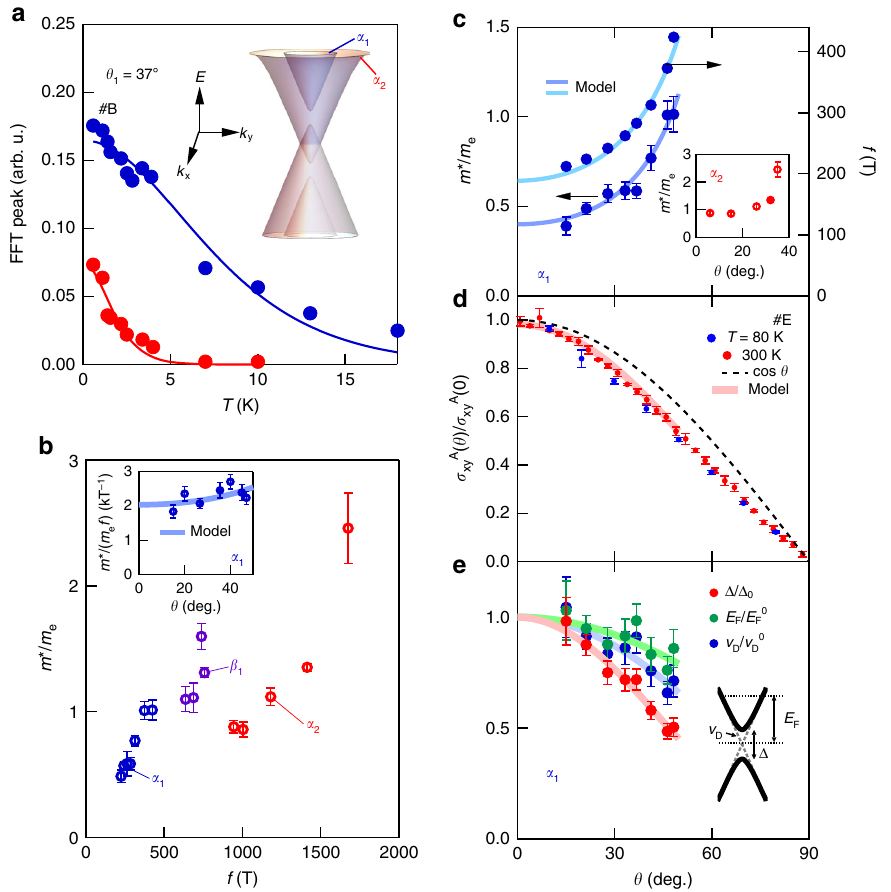
Fig. 3 Massive Dirac model of de Haas – van Alphen effect in Fe 3 Sn 2 . a Temperature dependence of oscillation amplitude and Lifshitz – Kosevich fi tting of f = 1675 T ( α 2 ) and 283 T ( α 1 ) at θ 1 = 37°. The inset shows a schematic of the double Dirac spectrum. b The observed effective mass m ∗ / m e versus oscillation frequency f for observed Fermi pockets. The inset shows the angular dependence of the ratio m ∗ / m e f for α 1 along with the massive Dirac model (see text). c Angular dependence of m ∗ / m e and f for the inner Dirac pocket (outer m ∗ / m e pocket shown in the inset), and d anomalous Hall conductivity σ A xy normalized to the zero-angle value ( σ A xy 0 ð Þ ¼ 130 Ω (cid:4) 1 cm (cid:4) 1 at 300 K and σ A xy 0 ð Þ ¼ 169 Ω (cid:4) 1 cm (cid:4) 1 at 80 K), respectively, with solid curves showing the massive Dirac model (see text). e Angular dependence of the massive Dirac band parameters where the gap is normalized to Δ 0 ¼ 32 meV , the Dirac ¼ 2 : 2 ´ 10 5 m (cid:6) s (cid:4) 1 , and the Fermi energy is normalized to E 0 ¼ 112 meV with a schematic Dirac band shown in the inset. Error velocity normalized to v 0 D F bars correspond to standard errors in least-squares fi